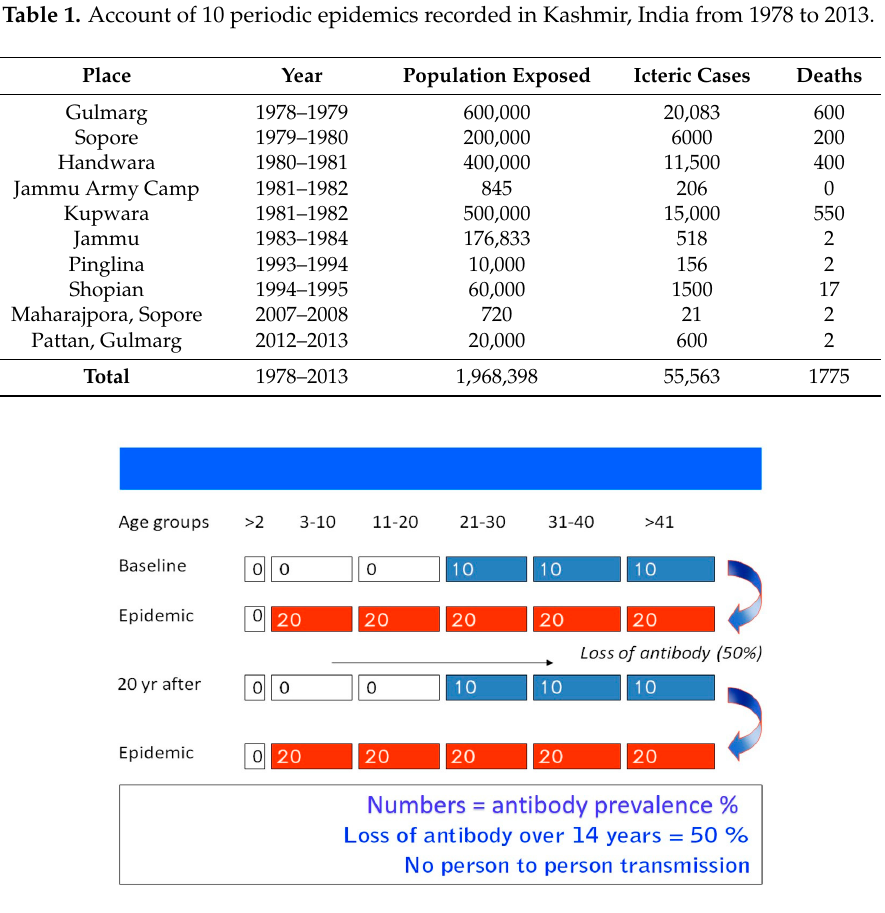
Figure 4. Suggested model of repeated hepatitis E epidemics in hyperendemic areas. IgG anti-Hepatitis E virus (anti-HEV) positivity in the general population is around 4%. Following the epidemic, around 20% are sero-positive. There is a general decline in sero-positivity of IgG anti-HEV and poor exposure to HEV infections during the inter-epidemic period. Repeat outbreaks occur when sero-positivity is around 4% and there is gross fecal contamination of drinking water sources (Adapted from Khuroo, et al. [4]).